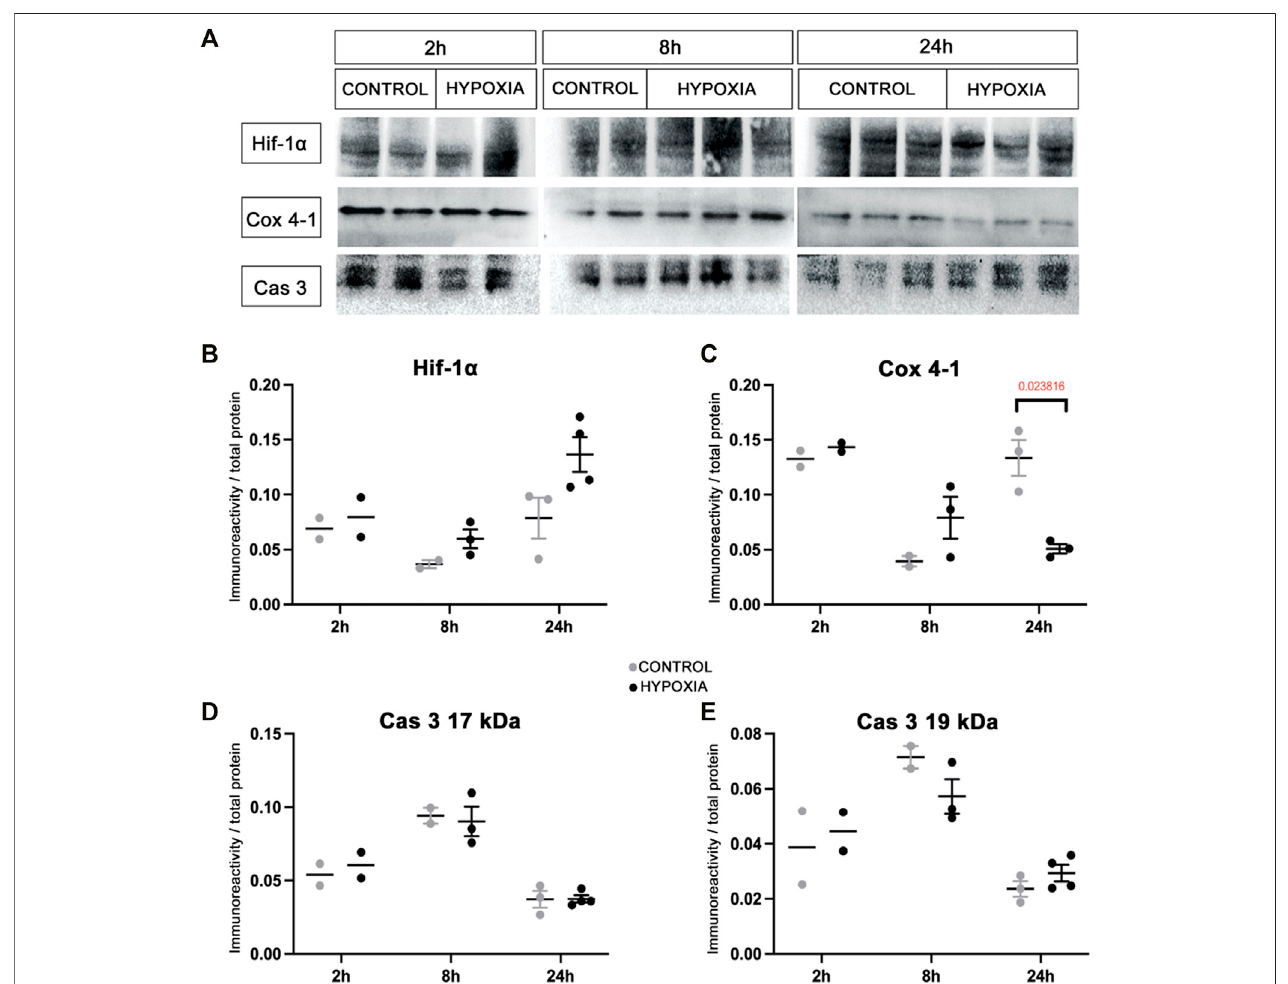
FIGURE 2 | Expression of the hypoxia-related proteins in the brain tissue of control and hypoxia-treated animals con fi rms moderate hypoxic lesion. (A) Representative Western blots of hypoxia-inducible factor-1 alpha (Hif-1 α ), cytochrome C oxidase subunit-4 isoform-1 (Cox 4-1), and cleaved caspase 3 (Cas 3) from brain samples obtained at 2, 8, and 24 h post hypoxia. The results of quanti fi cation of protein signal intensity is shown in correspondence to total protein amount (in Suplementary material suppl. Figure 1 ). (B) Notable changes in expression of Hif-1 α (control 0.078 ± 0.011, hypoxia 0.136 ± 0.008), and (C) Cox 4-1 (control 0.133 ± 0.009, hypoxia 0.051 ± 0.003, p = 0.024, Student ’ s t- test) were measured in the samples obtained 24 h after the hypoxia. There is no difference between the groups at earlier time points. (D,E) There is no observed difference in Cas 3 expression in the brain tissue between the control and hypoxia group at any time point.